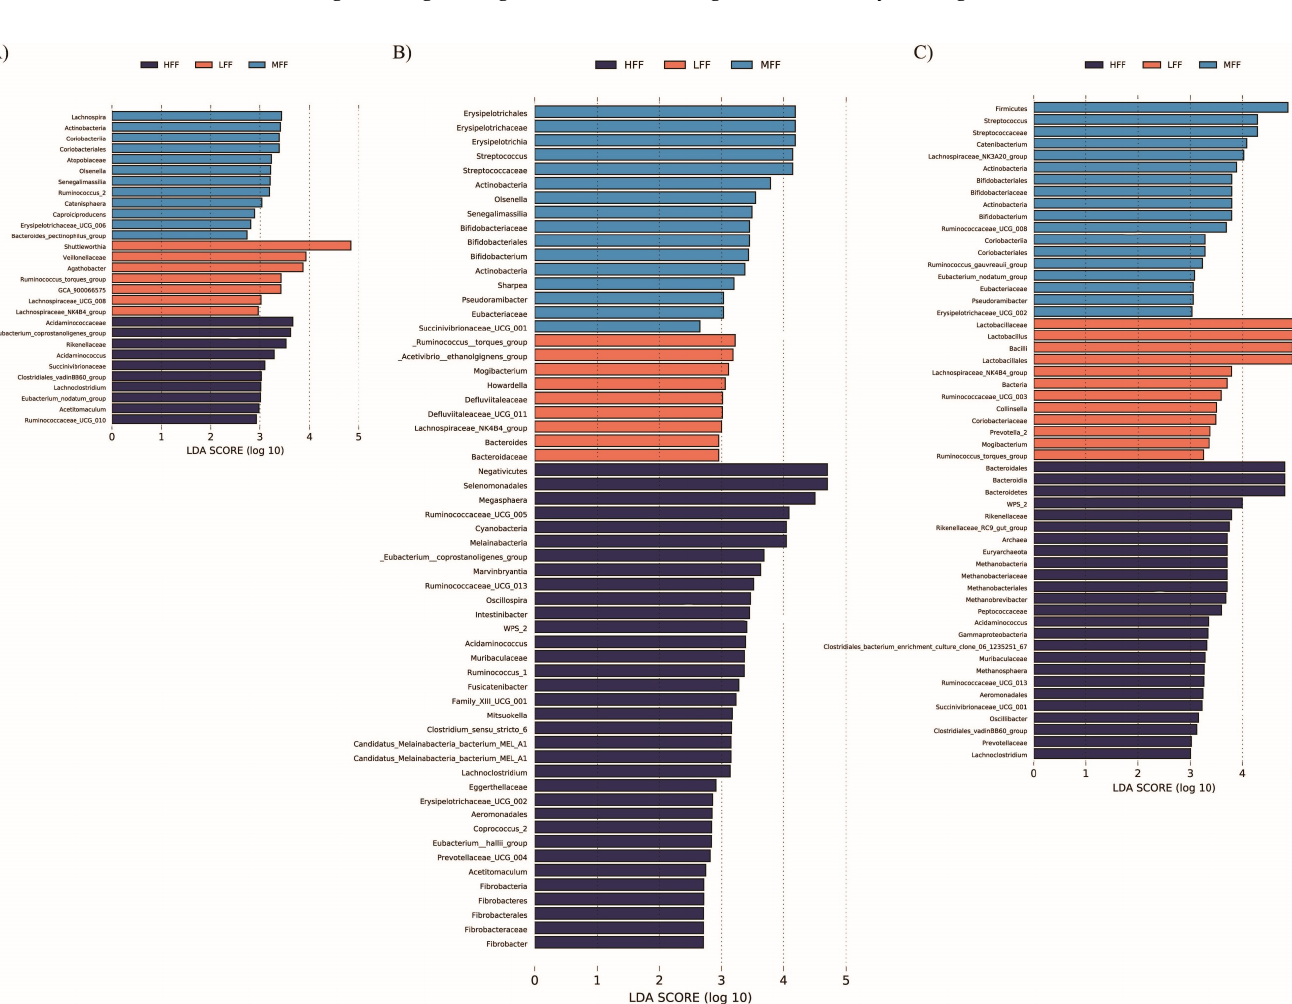
Figure 5. Annotated results from linear discriminant analysis in microbiota samples from pigs fed a lowly fermentable diet (LFF), an intermediate fermentability diet (MFF), and a highly fermentable diet (HFF) and inoculated with Brachyspira hyodysenteriae . All pigs were inoculated with B. hyodysenteriae at days post inoculation (dpi) 0 and fecal microbiota was assessed at ( A ) dpi 0, ( B ) dpi 12, and ( C ) dpi